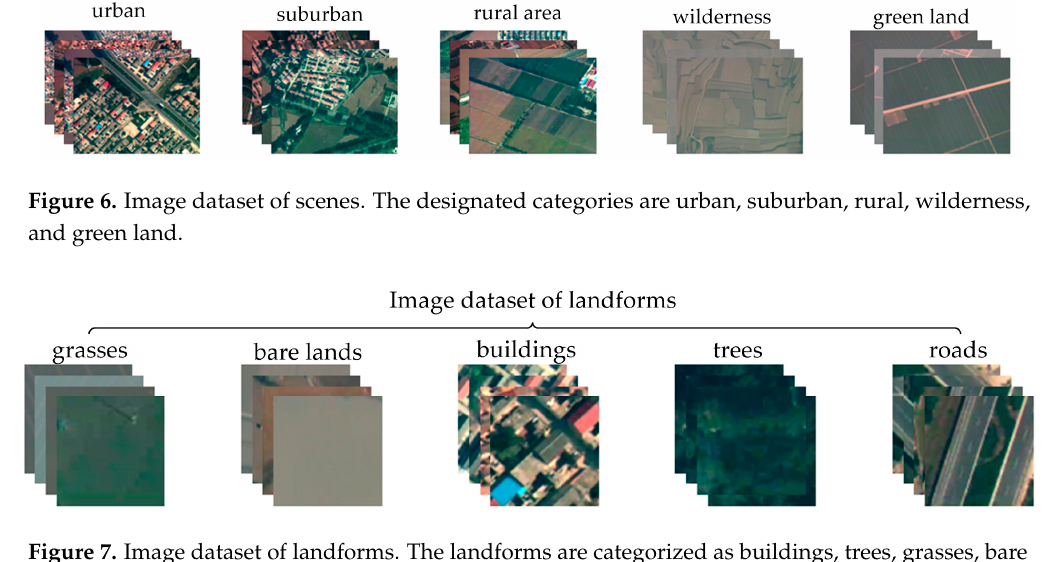
Table 1. Influence of filter template size on recognition results. Template Size